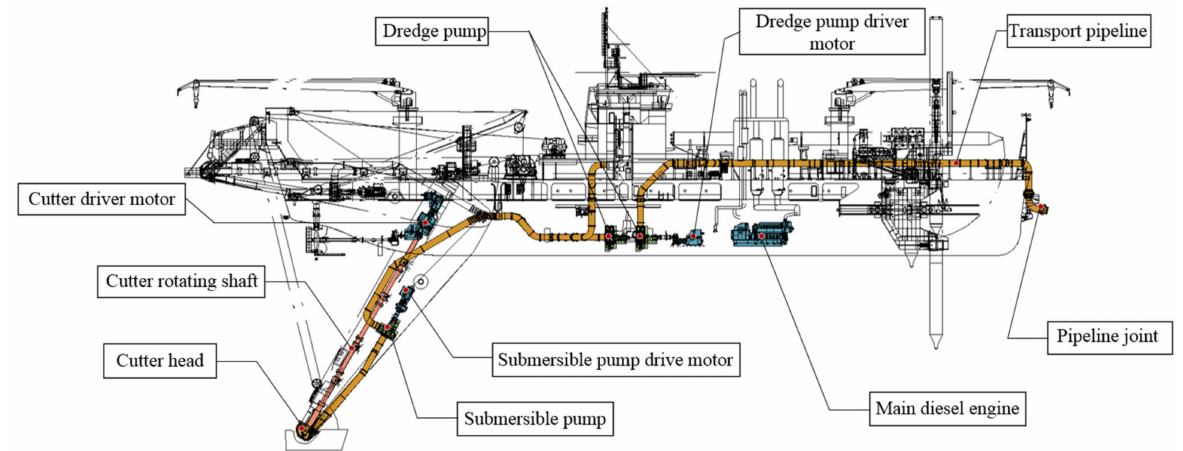
Figure 3. The primary system highlighted in cutter suction dredger